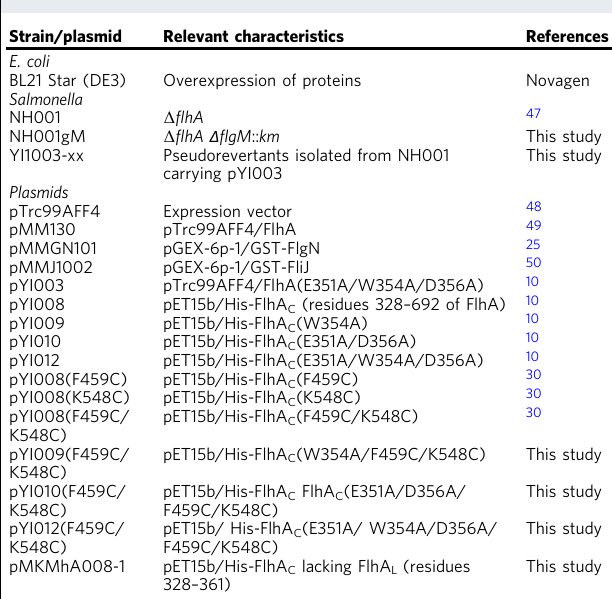
Table 2 Strains and plasmids used in this study.